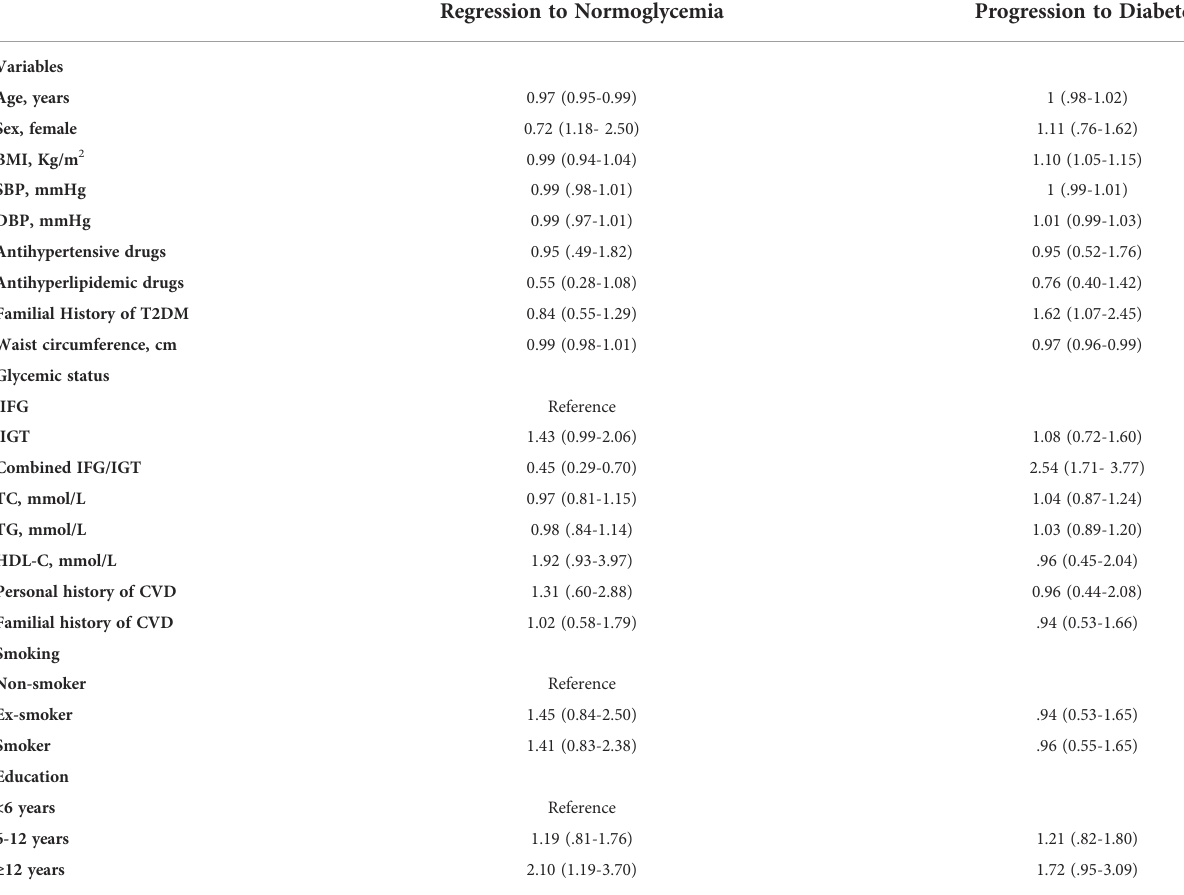
TABLE 4 Prognostic factors associated with regression and progression in prediabetes over a 10-years follow ‐ up in a multi-variable analysis a . Regression to